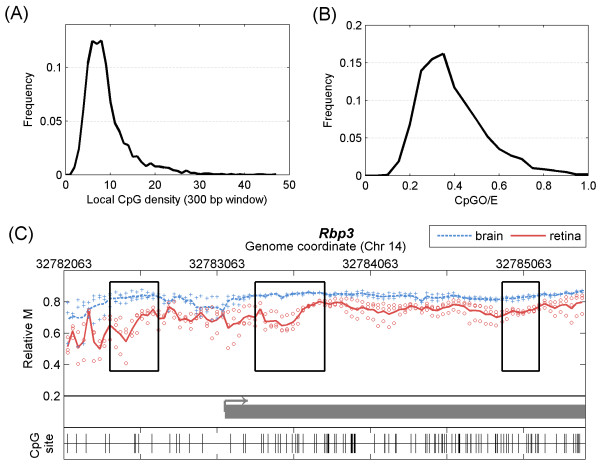
MBD2 enrichment by MeKL-chip enables detection of differential methylation over a range of CpG densities and CpGO/Es. (A) CpG density and (B) CpGO/E at each T-DMR was calculated over a 300 bp window. A range of CpG densities was observed, but the majority of T-DMRs were within low-CpG density regions. (C) Three T-DMRs (black boxes) associated with the retina-specific gene Rbp3 for the retina (red, solid) and brain (blue, dashed) are shown. The TSS (arrow) and a portion of Exon 1 are shown in grey. The three T-DMRs had varying CpGO/Es: 0.31 (left box), 0.38 (central box) and 0.47 (right box), and local CpG densities: 4.6 (left box), 9.4 (center box) and 13.2 (right box). CpGO/E: observed-to-expected CpG ratio; MeKL: MBD2b/MBD3L1 enrichment of DNA followed by KLM-PCR; T-DMR: tissue-specific differentially methylated region; TSS: transcription start site.